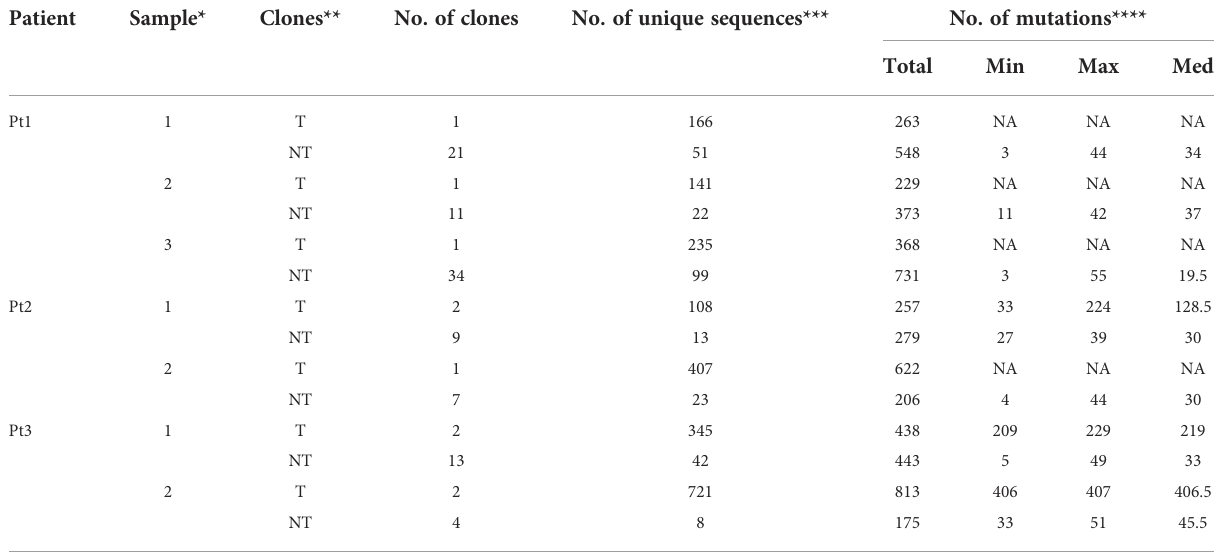
TABLE 1 Numbers of clones, unique sequences and mutations in tumor and non-tumor clones in each sample, in each patient.